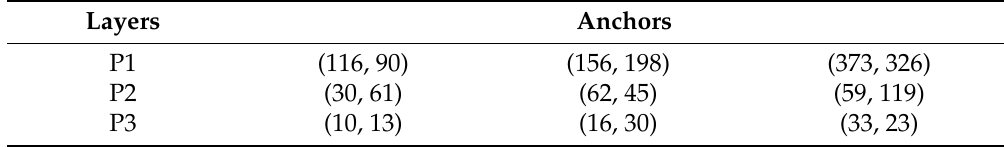
Table 1. The specific sizes of the anchors on the three prediction feature